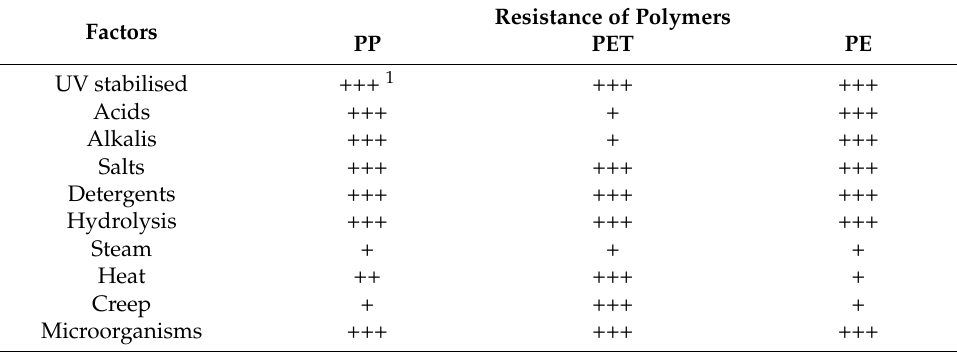
Table 2. Resistance of commonly used polymers in geosynthetics.